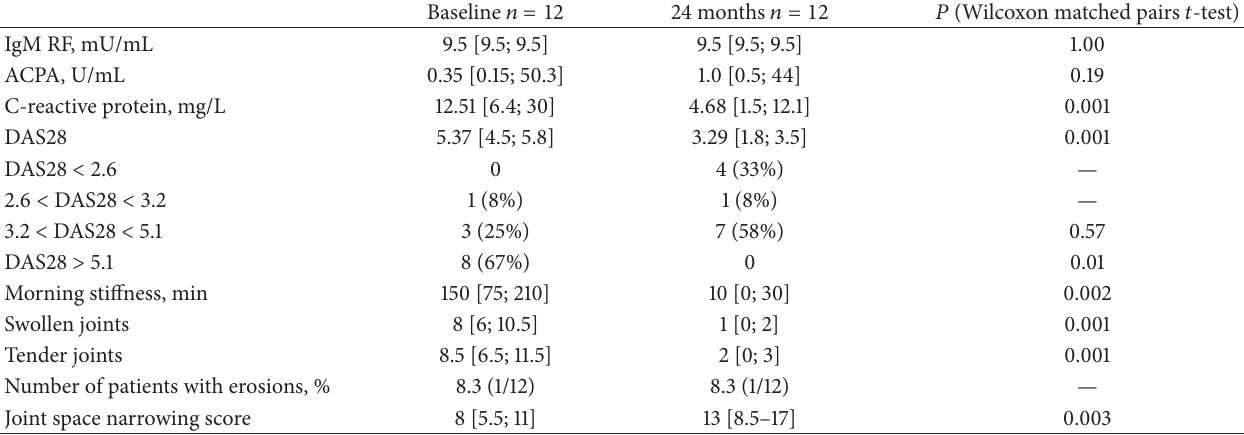
Table 2: Clinical, immunological, and radiological parameters and therapeutic response in seronegative rheumatoid arthritic patients.